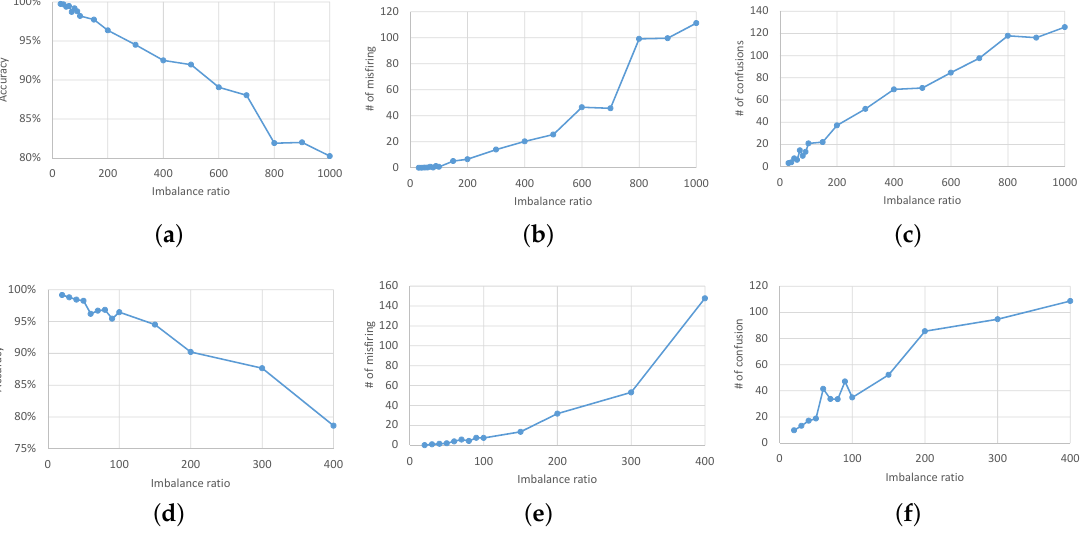
Figure 8. Test results for fixed normal data at 20,000 and changing ratio of data imbalance: ( a ) accuracy, ( b ) misfiring, and ( c ) confusion. Test results with fixed normal data to 10,000: ( d ) accuracy, ( e ) misfiring, and ( f )